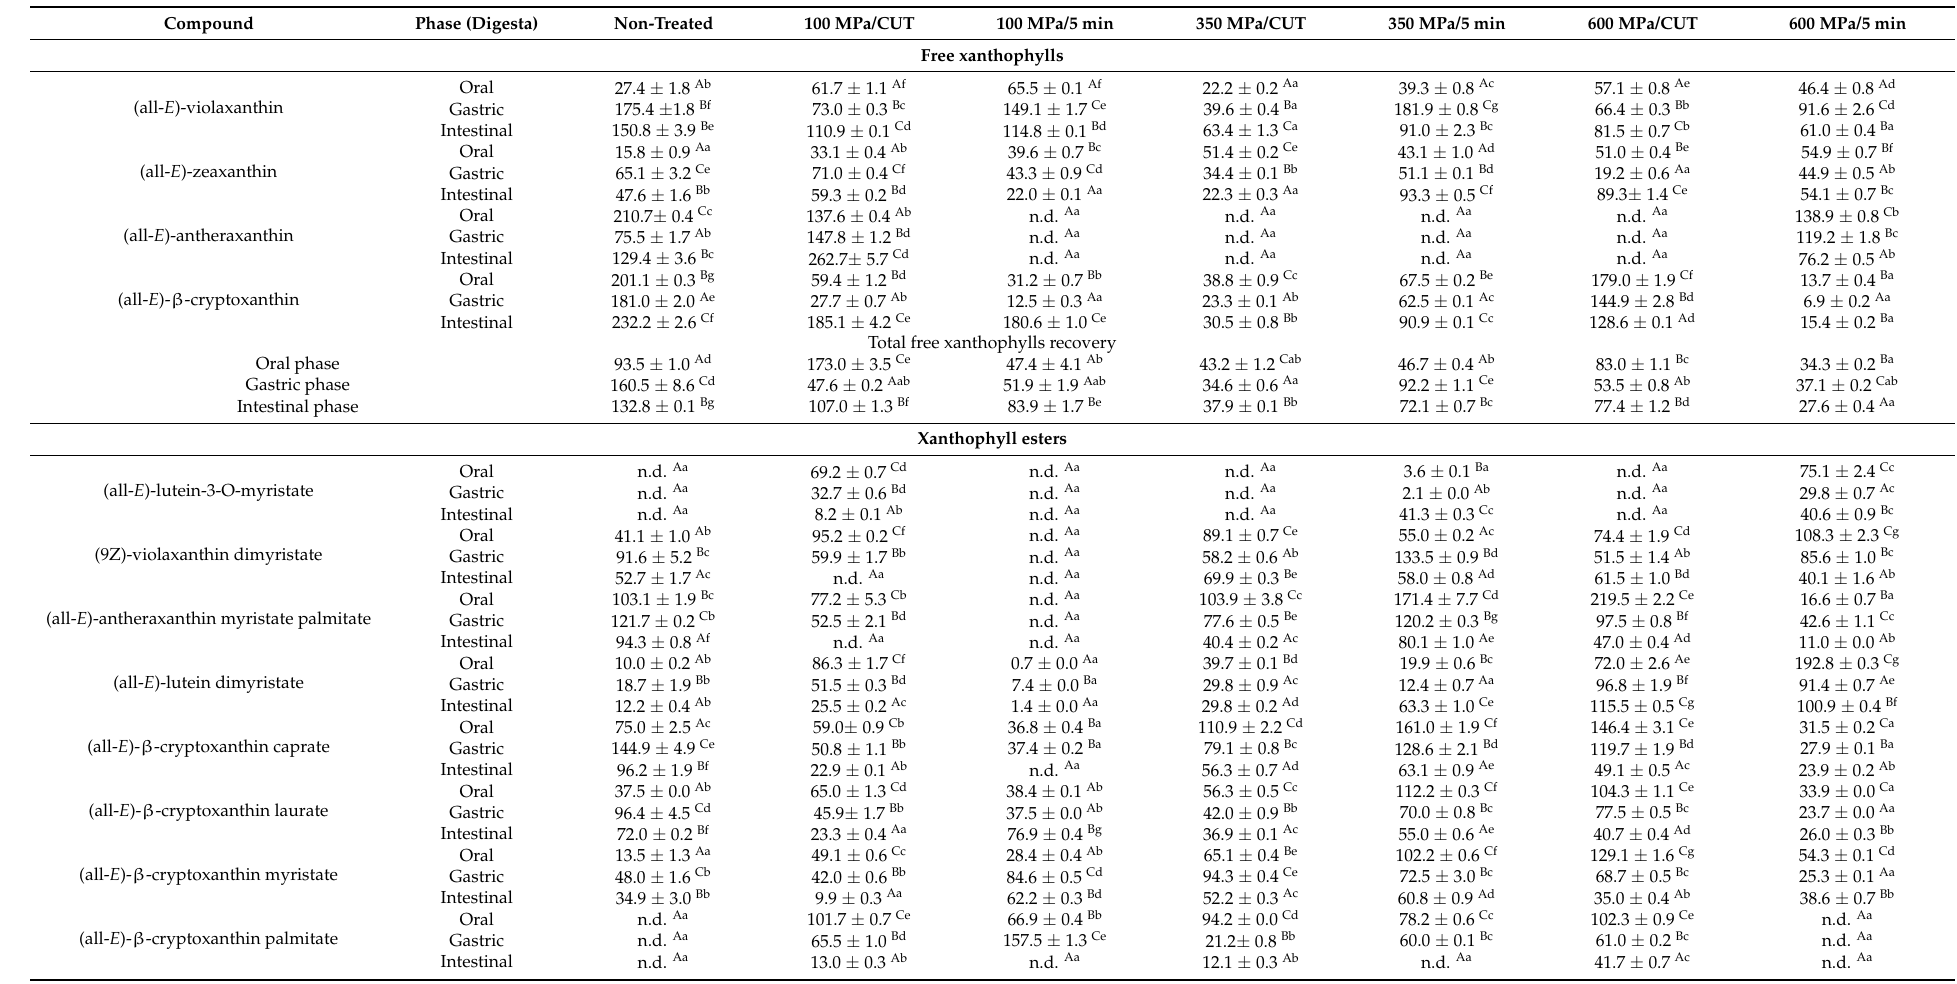
Table 2. Carotenoid recovery (%) 1 after in vitro simulated gastrointestinal digestion of Sweet Mary papaya ( Carica papaya L.) variety submitted to HHP treatments (100, 350 and 600 MPa at CUT and 5